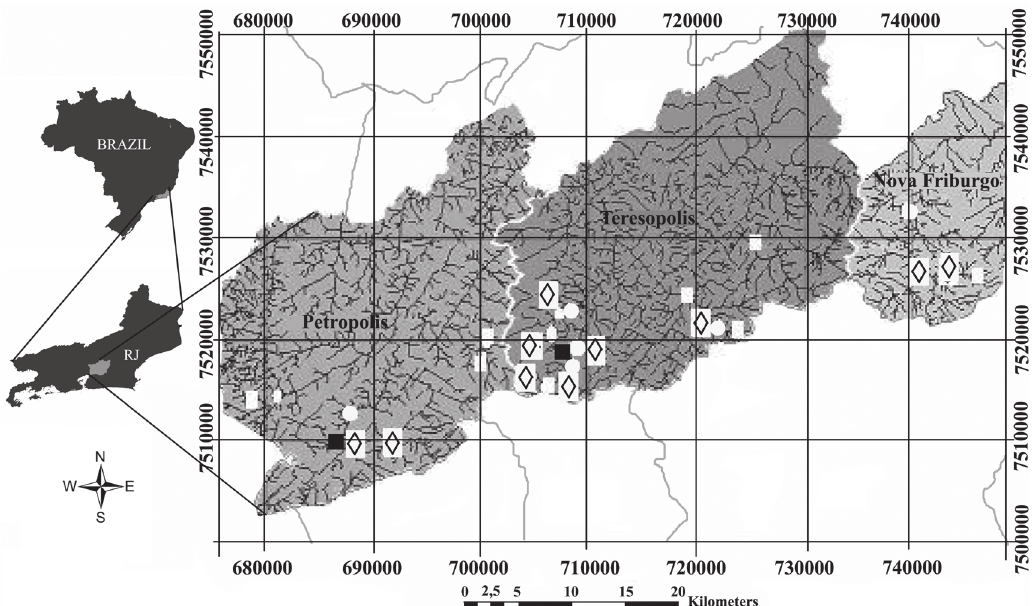
Figure 1. Map of Brazil and the study site in state of Rio de Janeiro. Light grey areas indicate limits of the Piabanha-Paquequer-Preto rivers watershed. White solid points indicate the macroinvertebrate assemblage sampling sites. Reference areas (white squares), im- paired areas (circles) and intermediate areas (diamonds). Municipality (black squares).